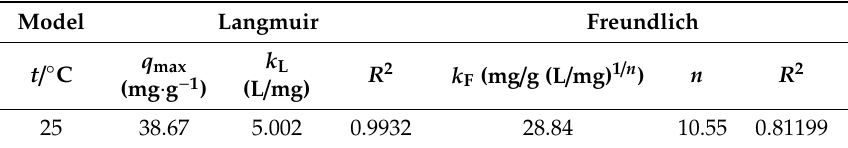
Table 4. Isothermal adsorption parameters of Langmuir and Freundlich.